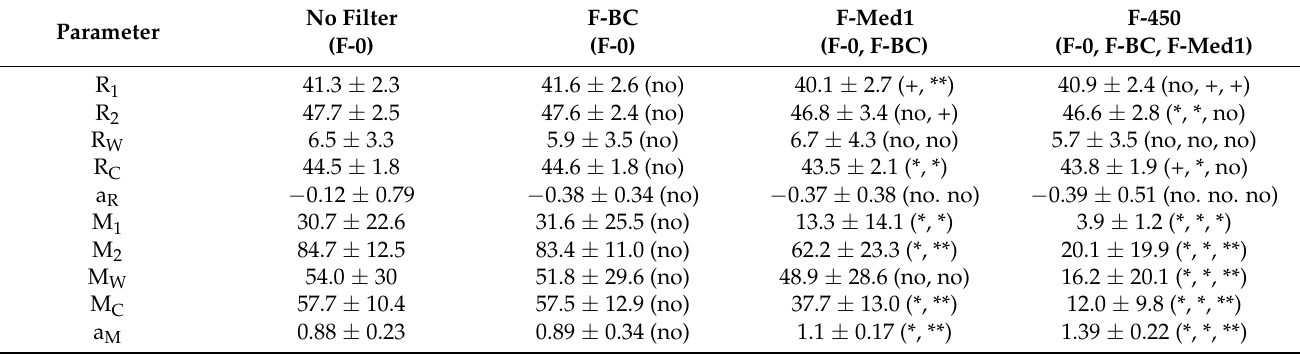
Table 2. The results for the analyzed parameters (mean ± standard deviation) and statistical significance of the differences in the Wilcoxon test as compared to the results in the preceding columns; no—no significance, +— p < 0.05, *— p < 0.01, **— p < 0.001.